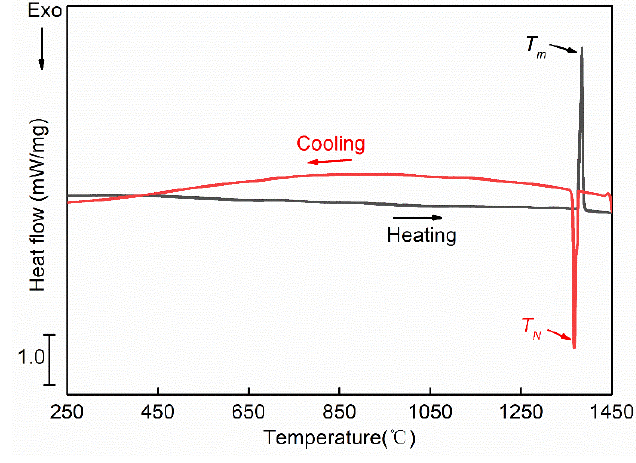
Figure 3. DSC curve of the as-cast Co 39.2 Ni 39.2 Al 21.6 EMEA.